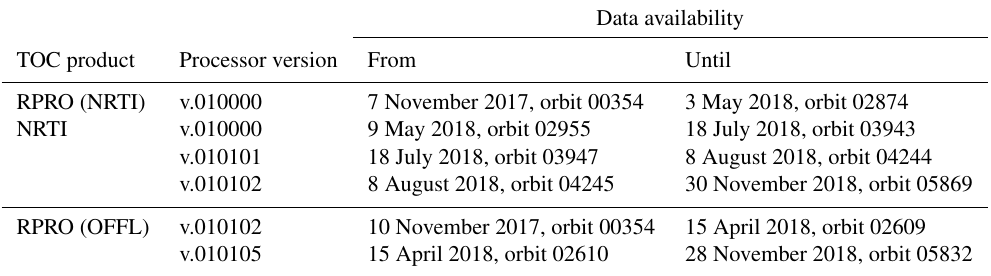
Table 1. The TROPOMI/S5P NRTI and OFFL TOC datasets used in this work.